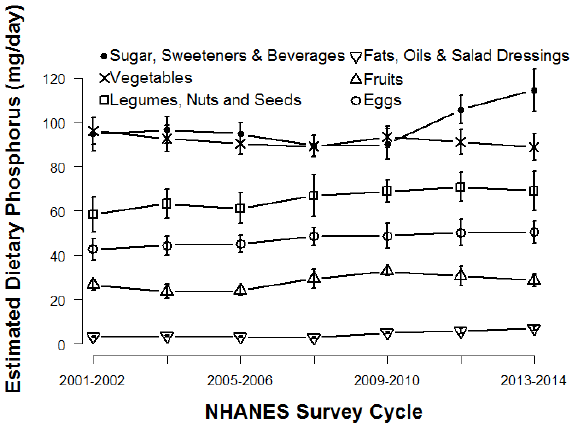
Figure 2. Estimated total dietary phosphorus contributed by the bottom 6 USDA food groups. Error